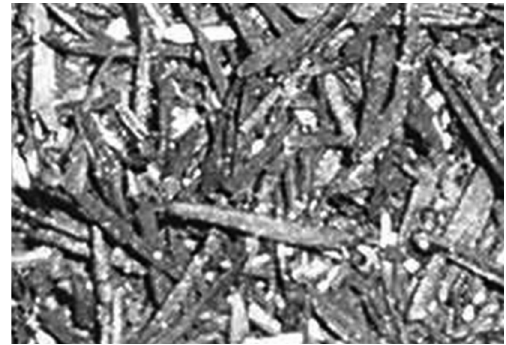
Figure 2. Macroscopy of RHA as received.